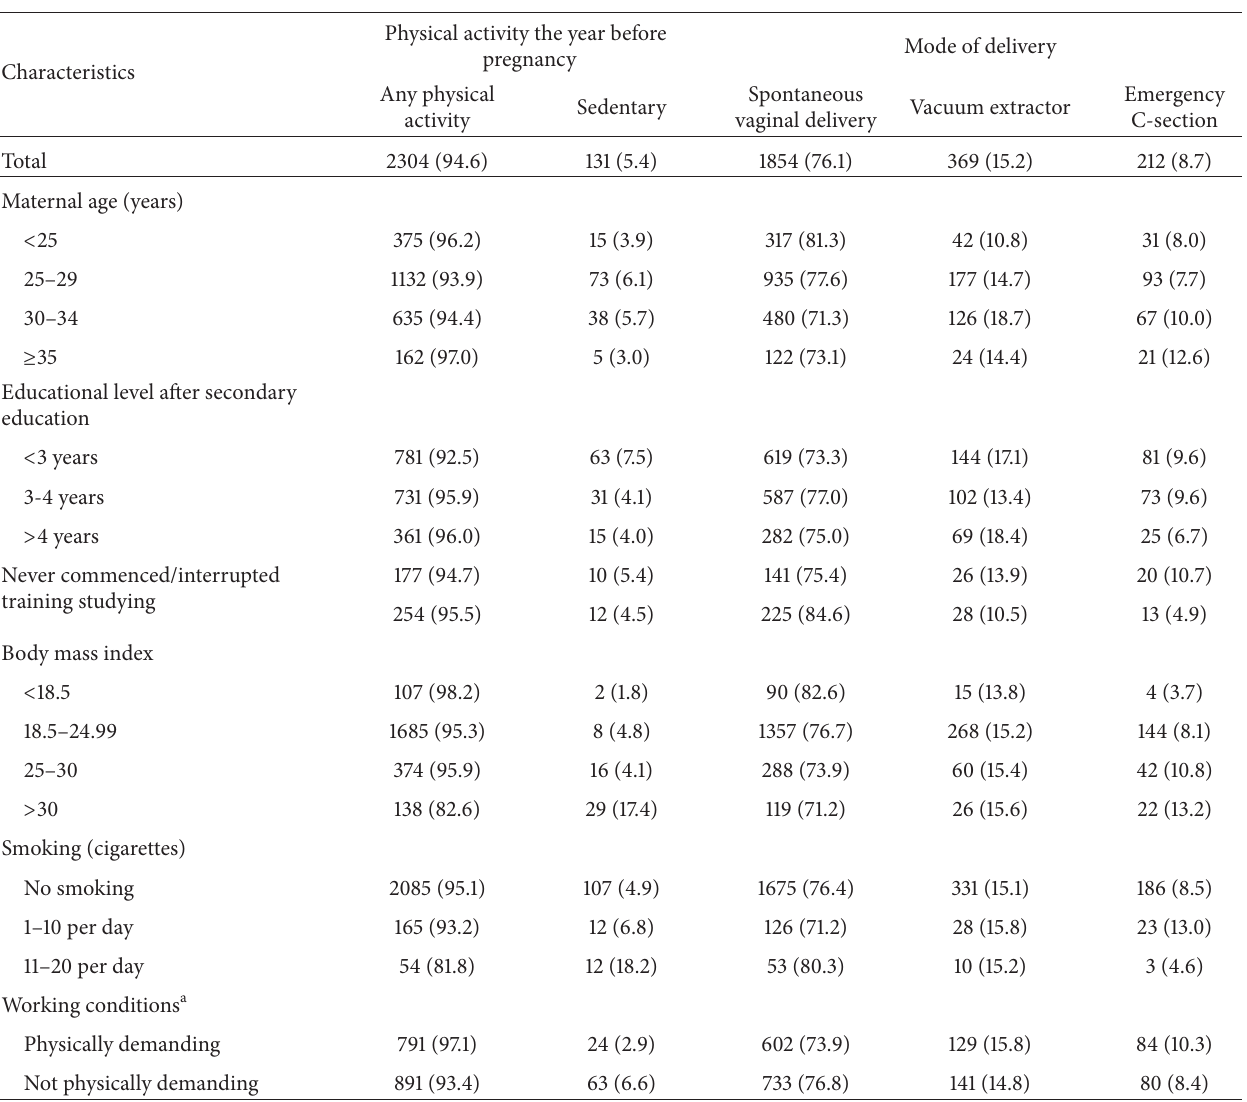
Table 2: Physical activity levels the year before pregnancy and mode of delivery according to maternal characteristics. The Danish Dystocia Study, 2004-2005. 𝑁 = 2435